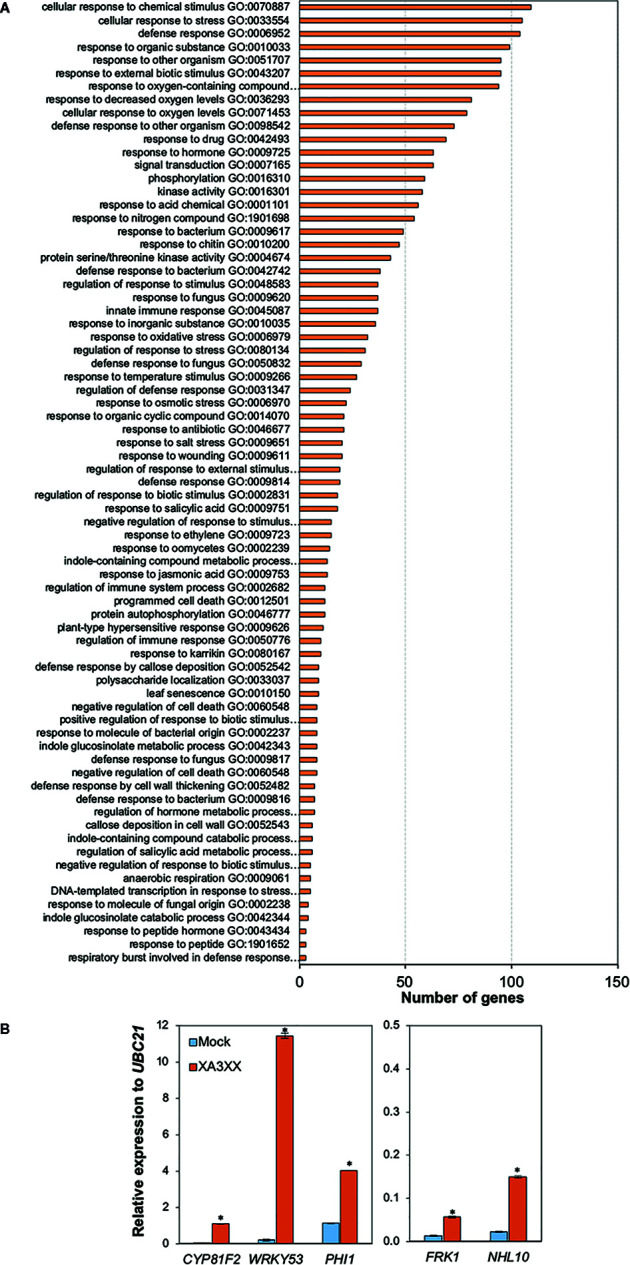
Functional classification of arabinofuranosyl-xylotetraose (XA3XX)-differentially expressed genes in Arabidopsis. (A) Biological process Gene Ontology (GO) term enrichment map of the 460 overexpressed genes in 12-d-old Arabidopsis Col-0 plants at 30 min after 250 μM XA3XX treatment. GO term enrichment is expressed as number of mapped genes. Data used to build the histogram can be retrieved from
Supplementary Table S2
. (B) RNA-seq data validation by quantitative RT-PCR analysis in 12-d-old Arabidopsis seedlings. Relative expression levels to UBC21 (At5g25769) gene at 30 min are shown. Data represent mean ± SD (n=3) from one experiment representative of two independent ones with similar results. Statistically significant differences between XA3XX and mock according to Student’s t-test (*p < 0.005).